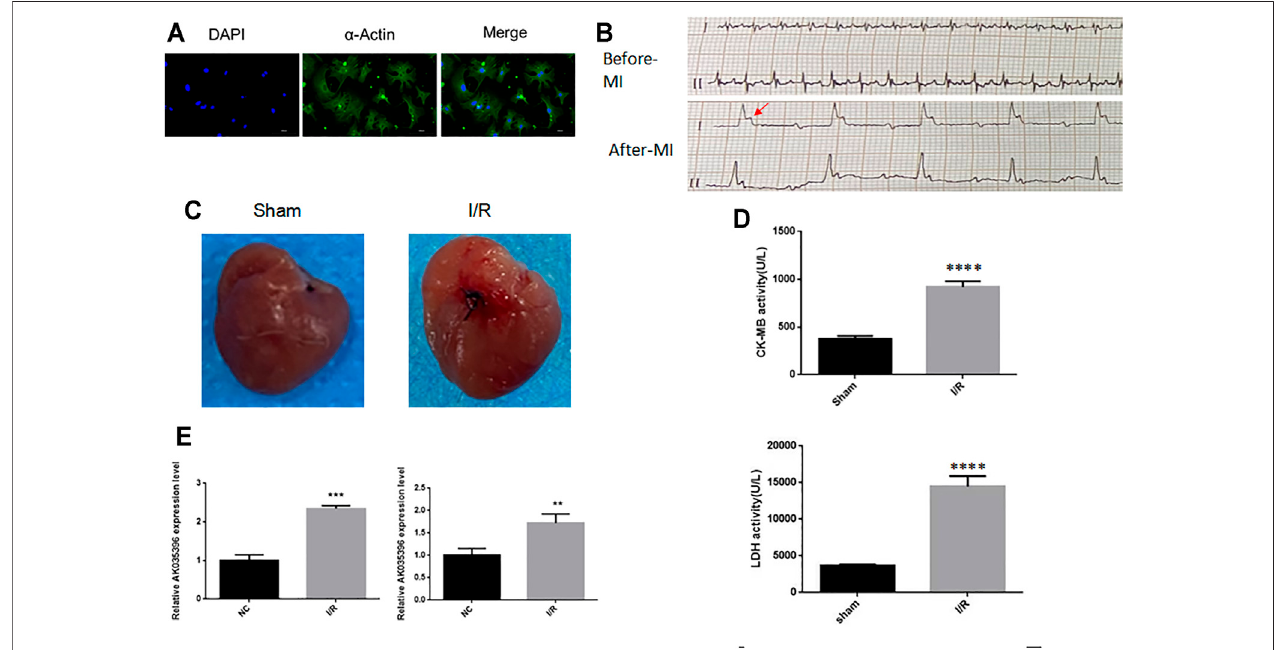
FIGURE 1 | The expression of AK035396 in the ischaemia-reperfusion model (A) Primary murine cardiomyocytes were isolated, and the purity of the cells was evaluated with α -Actin (Blue, DAPI) (Green, α -Actin). (B) Electrocardiogram of the mouse myocardial infarction model. The arrow indicates abnormal T waves. (C) Myocardial changes before and after myocardial infarction modelling in mice. (D) ELISA results showing that CK-MB and LDH were increased in mice with myocardial infarction. (E) After the hypoxia-reperfusion model was established in primary cardiomyocytes (left) and mice (right) , the expression of AK035396 was measured by qRT –